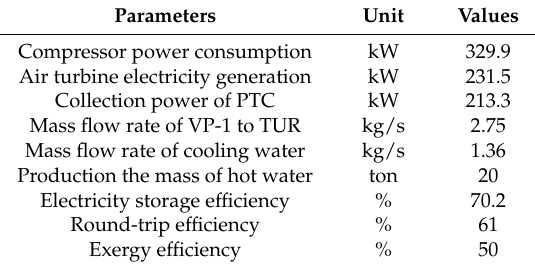
Table 4. Simulation results of the ST-CAES system under typical operational